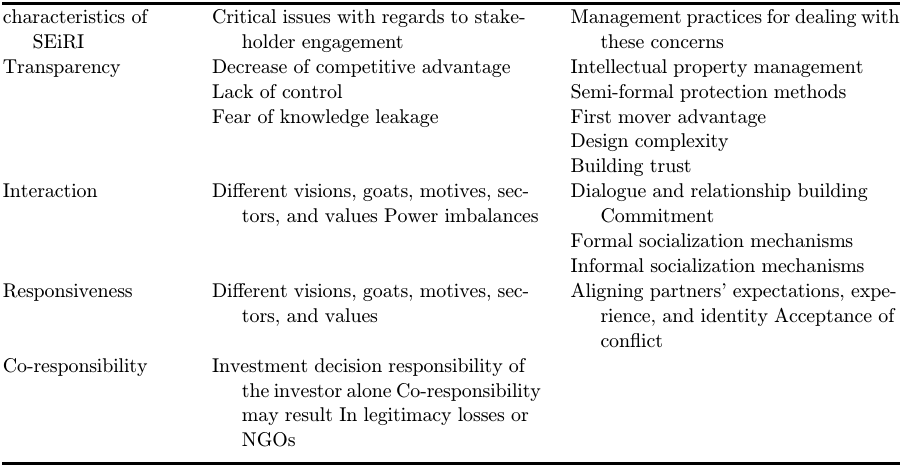
Table 1. Theoretical framework: critical issues with regard to stakeholder engagement in responsible innovation and management practices for dealing with these concerns. 11 characteristics of